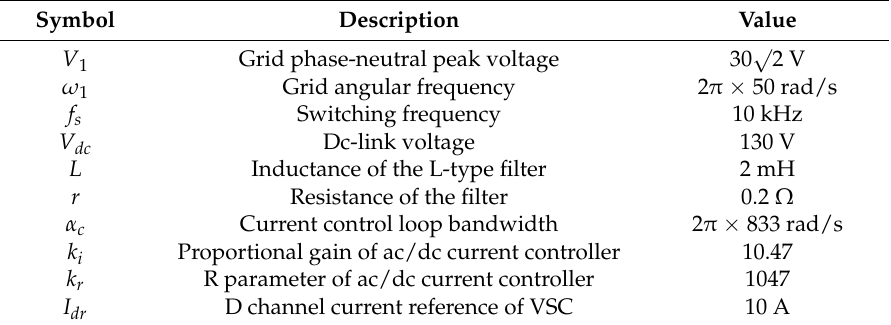
Figure 7. Magnitude responses of admittances of the converter synchronized by a DSOGI-FLL: ( a ) Y pp ( s + j ω 1 ); ( b ) Y pn ( s + j ω 1 ); ( c ) Y np ( s − j ω 1 ); ( d ) Y nn ( s − j ω 1 ). Red line: Implementation I; Green line: implementation II; Black line: implementation III is applied. Circles: numerical simulation results. Table 3. Parameters of grid-tied converter